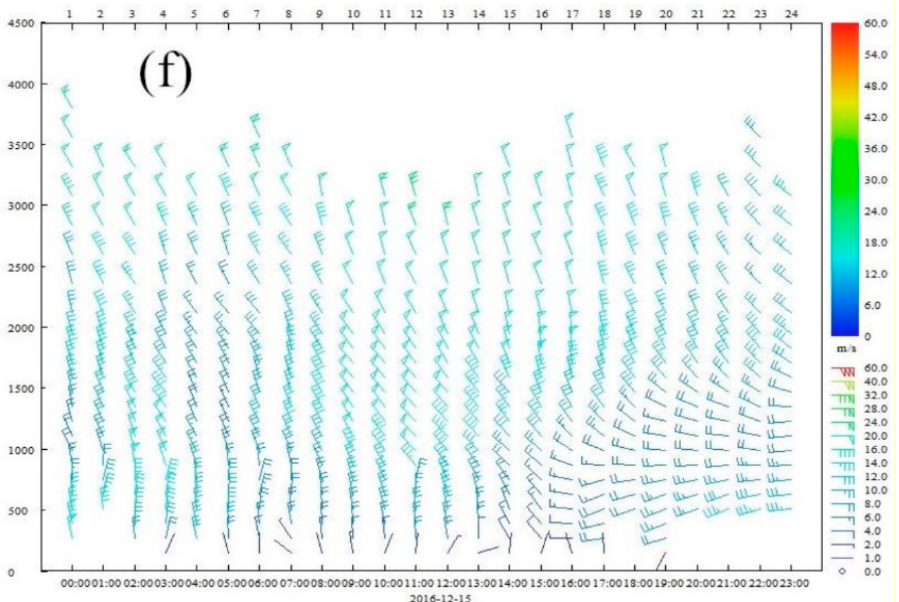
Figure 5. Temporal variations of ( a ) PM 2.5 mass concentration, specific humidity, ( b ) visibility, relative humidity, ( c ) wind speed, wind direction, and ( d ) TKE from 0000 LST 16 December to 2300 LST 22 December. All variables were observed at the surface except for TKE . ( e ) Profile of wind speed obtained from a 255-m meteorological tower from 0000 LST 16 December to 2300 LST 22 December. ( f ) Profile of wind speed obtained from the wind-profile radar from 0000 UTC (LST = UTC + 8) to 2300 UTC 15 December.